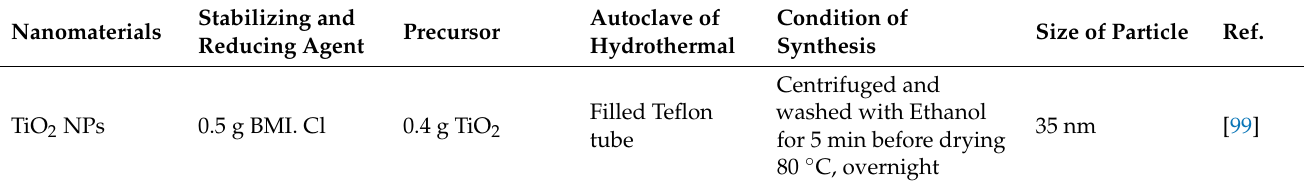
Table 4. Summary of the various approach involved with the hydrothermal